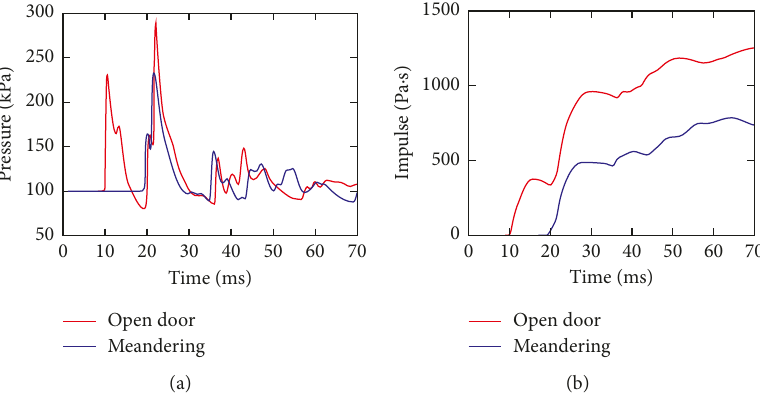
Figure 8: Comparison of (a) pressure and (b) impulse values for a point located in the protected zone for an “open door” model and a “meandering wall” model ( D 1m; E (cid:30) (cid:30)